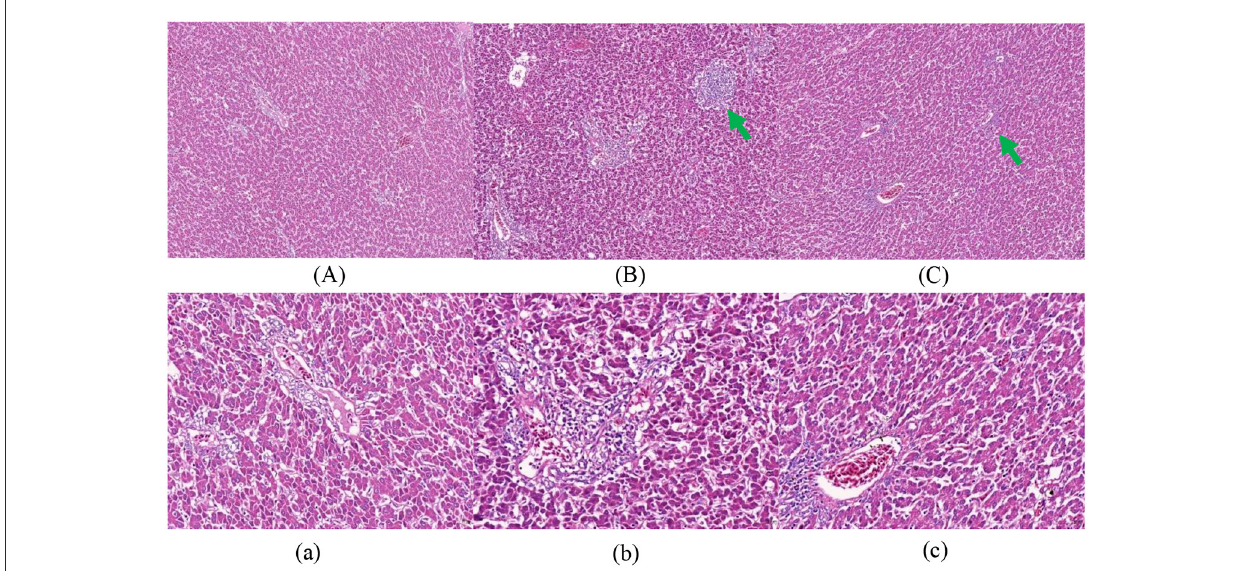
FIGURE1 The effect of non-fasting molting on liver tissue morphology (stage I). (A, a) Not treated with centralized molting; (B, b) fasting molting; (C, c) non-fasting molting. Upper-case letters are × 100, lower-case letters are × 400. Green arrows represent hepatocellular edema and blue arrows indicate the occurrence of steatosis.